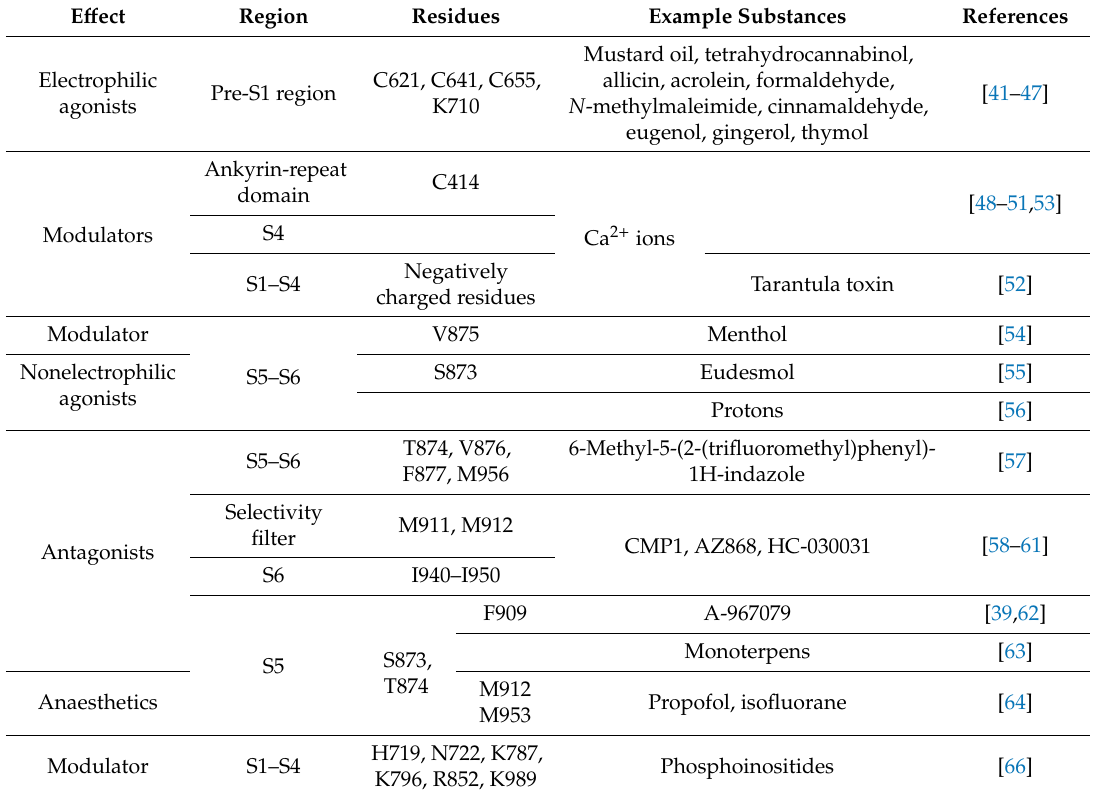
Table 1. Summary of action sites of the di ff erent TRPA1